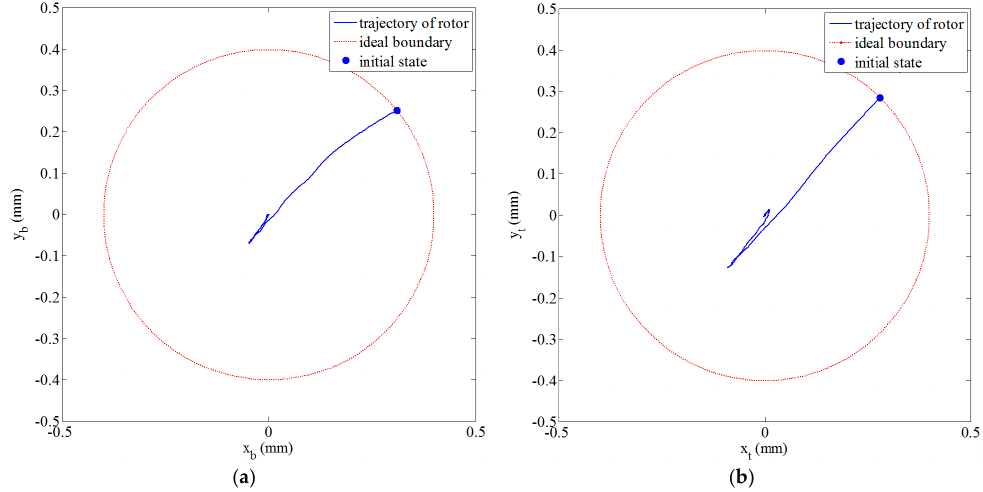
Figure 17. Experimental results: ( a ) rotor trajectory at the bottom HMB; and ( b ) rotor trajectory at the top HMB.